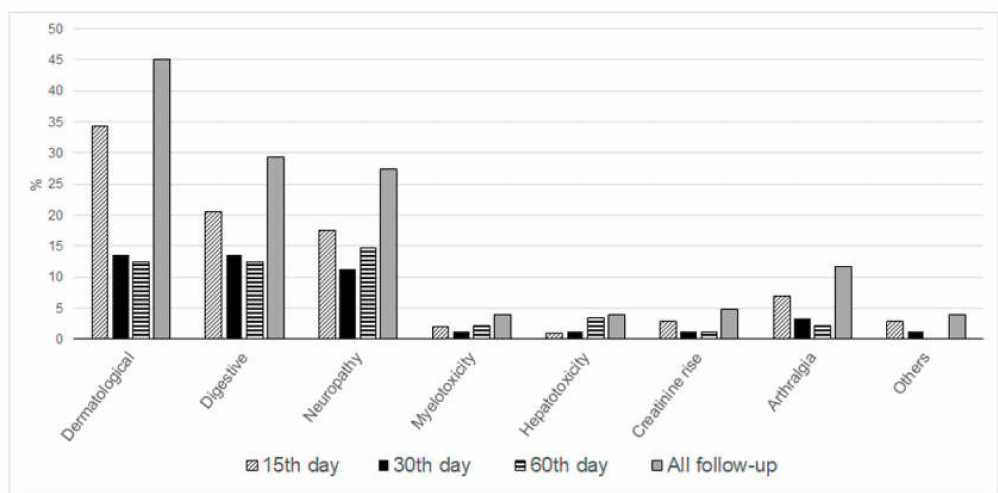
Figure 1. Adverse drug reactions at different follow-up visits: percentage of the whole cohort experiencing each type of adverse drug reaction (ADR), 15 (T15d), 30 (T30d) and 60 days (T60d) after BZN treatment initialization, across the whole follow-up period. ADRs grouped as dermatological, digestive, neurological, and other less common